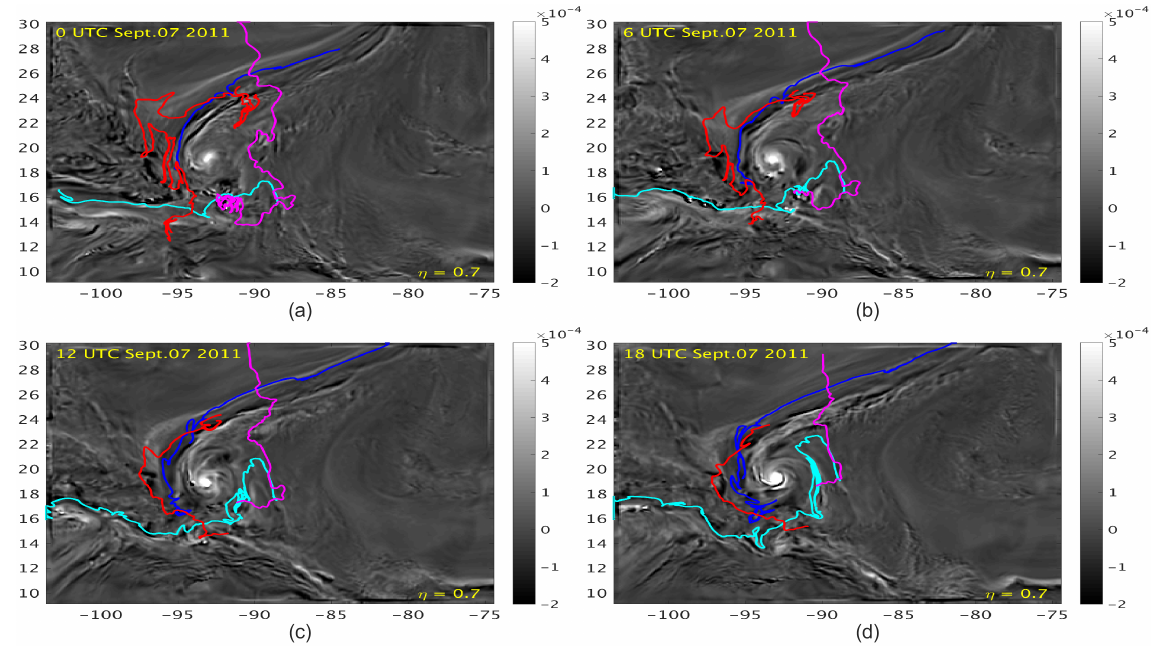
Figure 5. The stable (magenta, red) and unstable (blue, cyan) manifolds from the WRF simulation using non-uniform SSTs are overlaid on the vertical vorticity (s − 1 ) in panels (a–d)